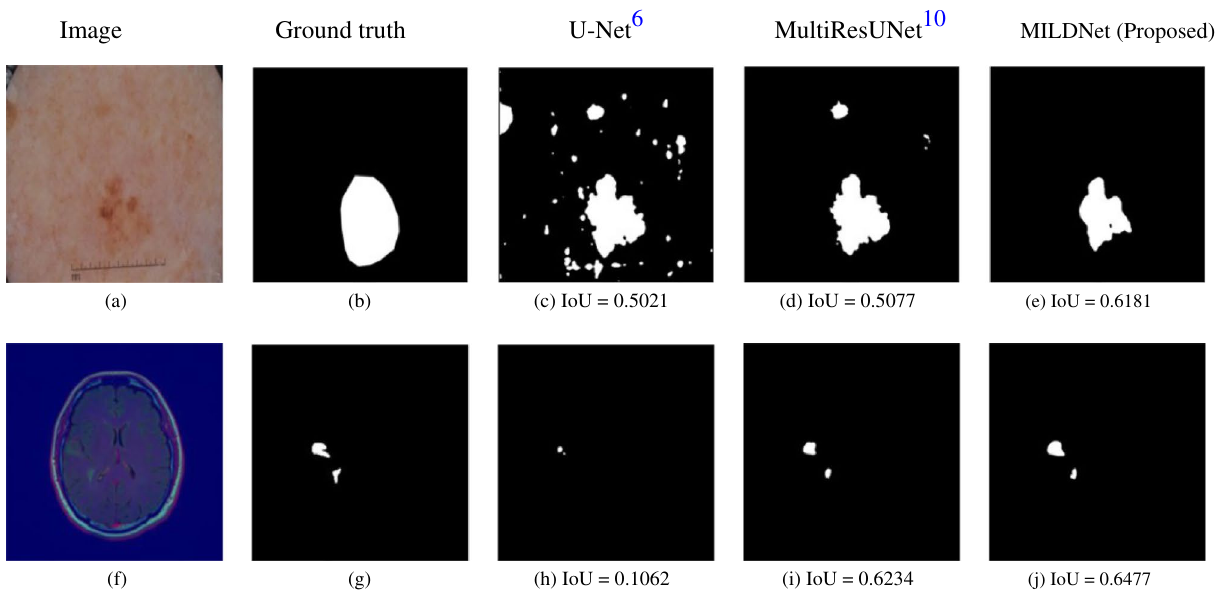
Figure 11. Segmenting a dermoscopy 11,12 image (a) and an MRI 15 image (f) having no clear boundaries separating the foreground and the background, with (b,g) demonstrating the ground truth segmentation masks. The classical U-Net either over-segmented (c) or under-segmented (h) the images, while the MultiResUNet (d,i) and the MILDNet (e,j) performed considerably better in the